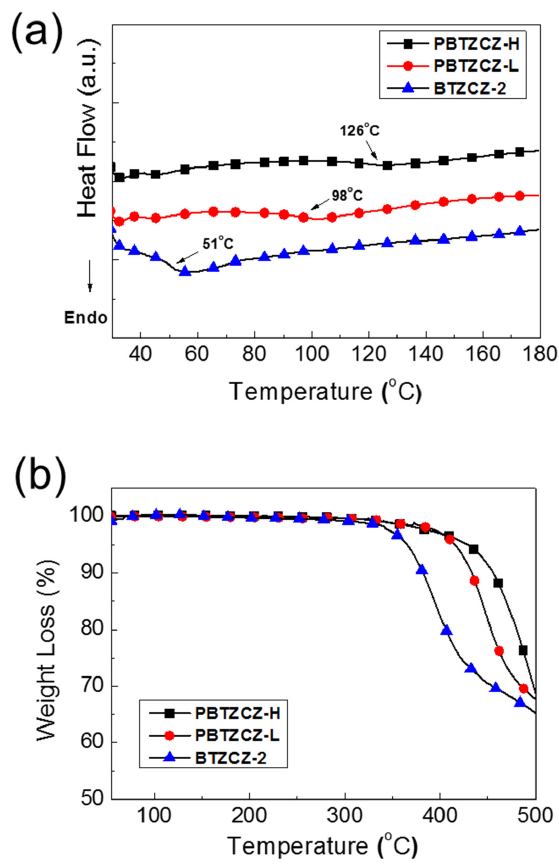
Figure 1. ( a ) DSC and ( b ) TGA data for BTZCZ-2 , PBTZCZ-L , and PBTZCZ-H samples showing thermal transition and thermal stability.